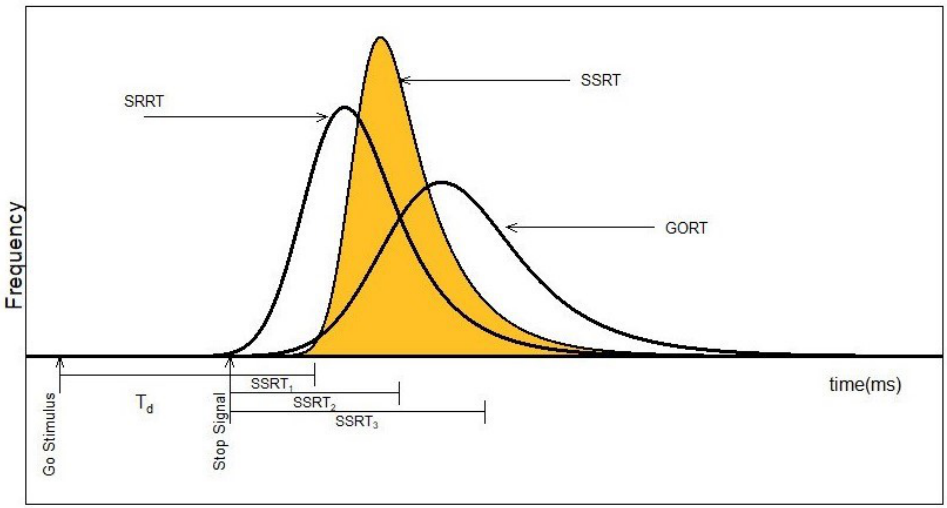
Figure 1. Graphical representation of the complete horse race model: GORT: go reaction times, SRRT: Signal respond reaction times, SSRT: Stop Signal reaction times, T d : stop signal delay